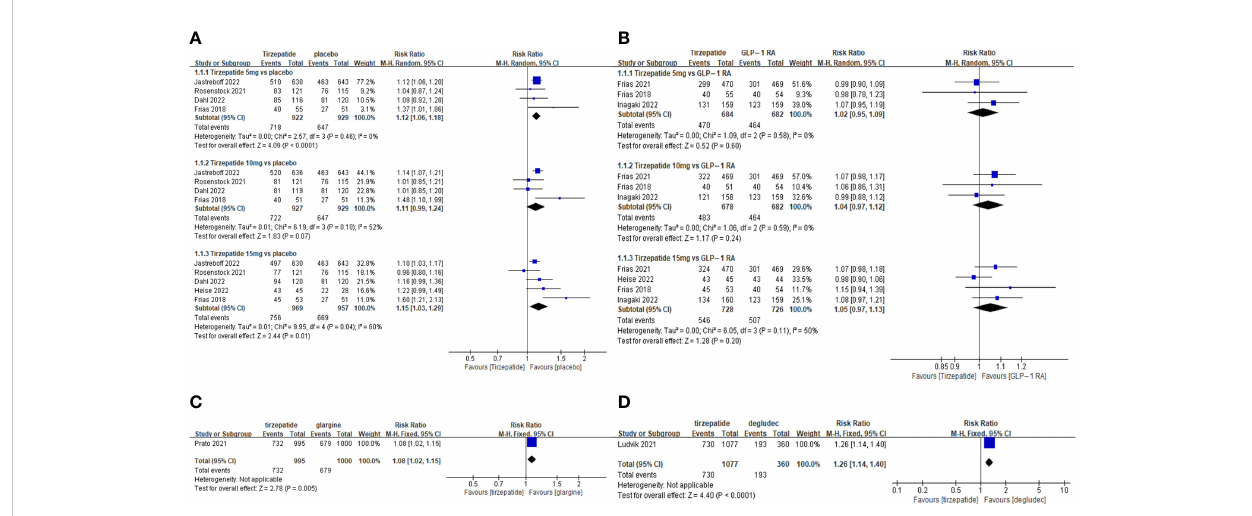
FIGURE 2 Meta-analysis results for tirzepatide of total adverse drug event: (A) tirzepatide vs placebo. (B) tirzepatide vs GLP-1RAs. (C) tirzepatide vs insulin glargine. (D) tirzepatide vs insulin